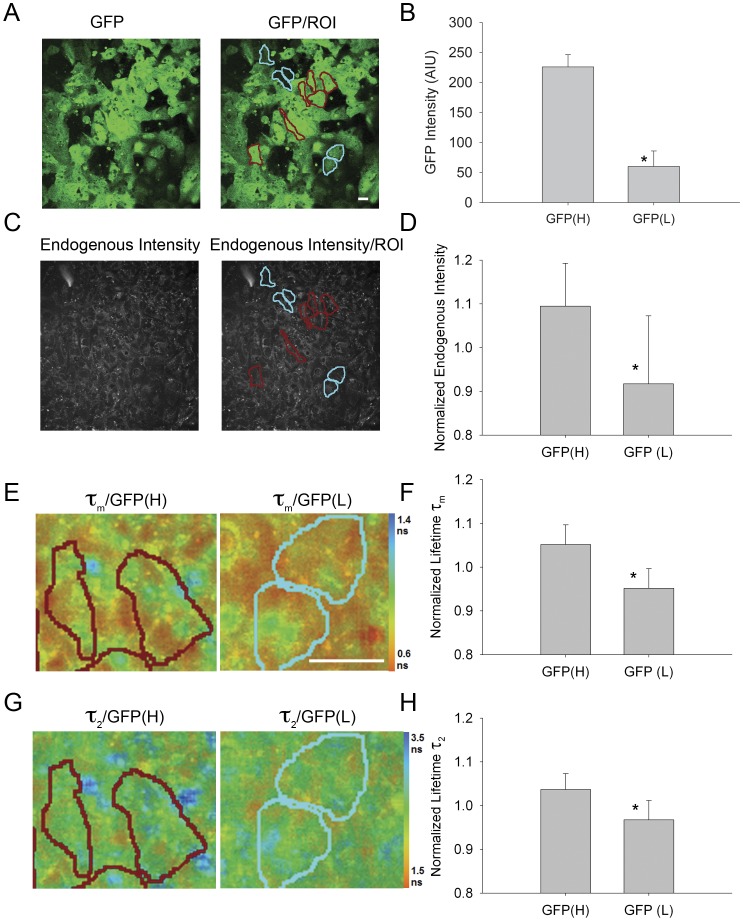
Cellular level changes in endogenous fluorescence intensity and lifetime with loss of pluripotency of hESCs.A. GFP intensity of MPLSM single optical section of live hESCs expressing pOct4:GFP: at 10 days post-EB formation using 890 nm excitation and 520/35 nm emission. Right image shows regions of interest (ROIs), roughly corresponding to single cells, with high intensity GFP (GFP(H)), outlined in red; low intensity GFP (GFP(L)), outlined in blue. B. Quantitative assessment of ROIs of GFP intensity. * indicates significant difference between GFP(H) ROIs and GFP(L) ROIs (P≤0.001). C. Intensity of the same MPLSM single optical section as (A) using 780 nm excitation and 457/50 nm emission corresponding primarily to NADH endogenous fluorescence. Right image shows same ROIs as (A). D. Quantitative assessment of ROIs of endogenous intensity. E. Color mapped mean lifetime (τm) images of endogenous fluorescence with quantitative assessment of ROIs (F). G. Color mapped long lifetime (τ2) images of endogenous fluorescence with quantitative assessment of ROIs (H). Scale bars = 20 µm. Color bar indicates lifetime values for τm (E) or τ2 (G). * indicates significant difference at P<0.01 (t-test).